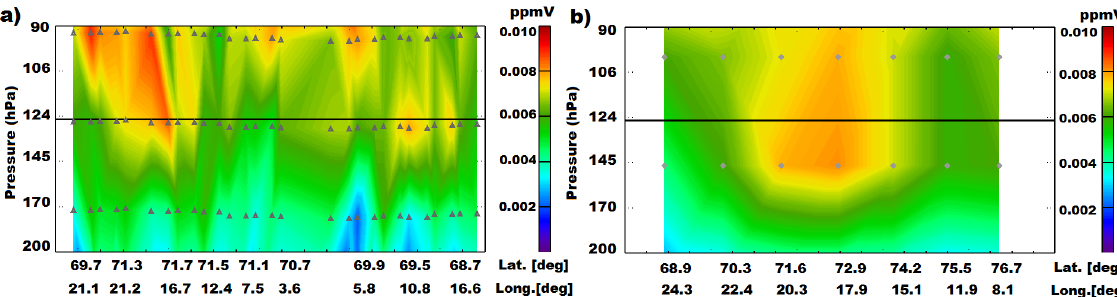
Fig. 12. (a) HNO 3 values retrieved from MARSCHALS as a function of pressure (from 90 to 200hPa) and latitude and longitude of the instrument during the flight. The black line corresponds to the 125hPa level while grey points represent the MARSCHALS retrieval grid points. (b) HNO 3 MLS/Aura values as a function of pressure and latitude, longitude for the scans marked with triangles in Fig. 2a.